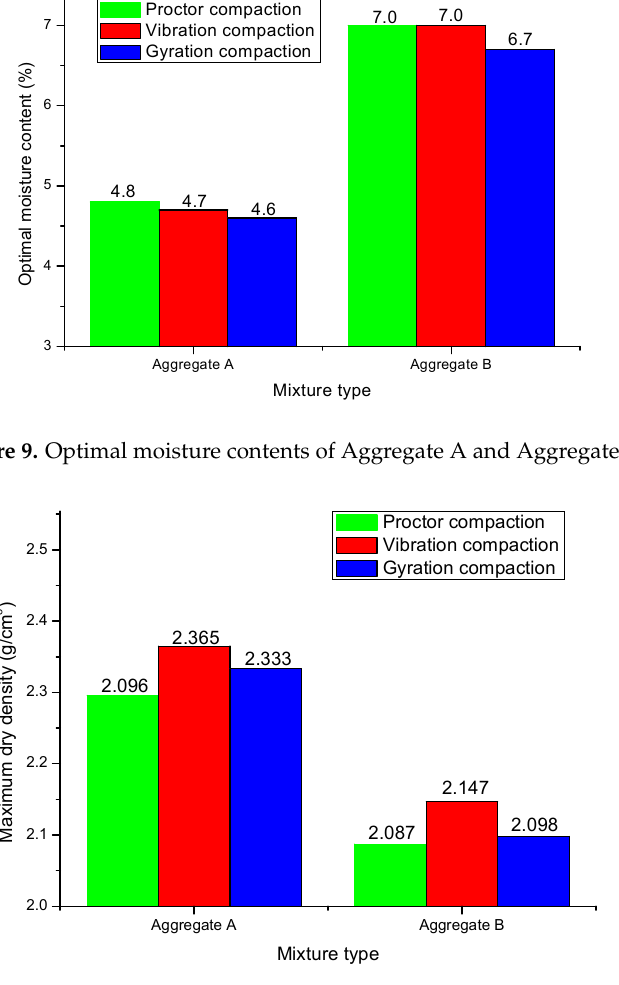
Figure 10. Maximum dry densities of Aggregate A and Aggregate B.